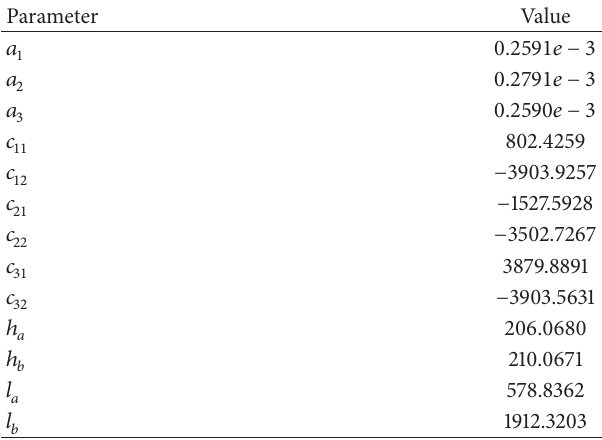
Table 2: The solution of three-span cable.